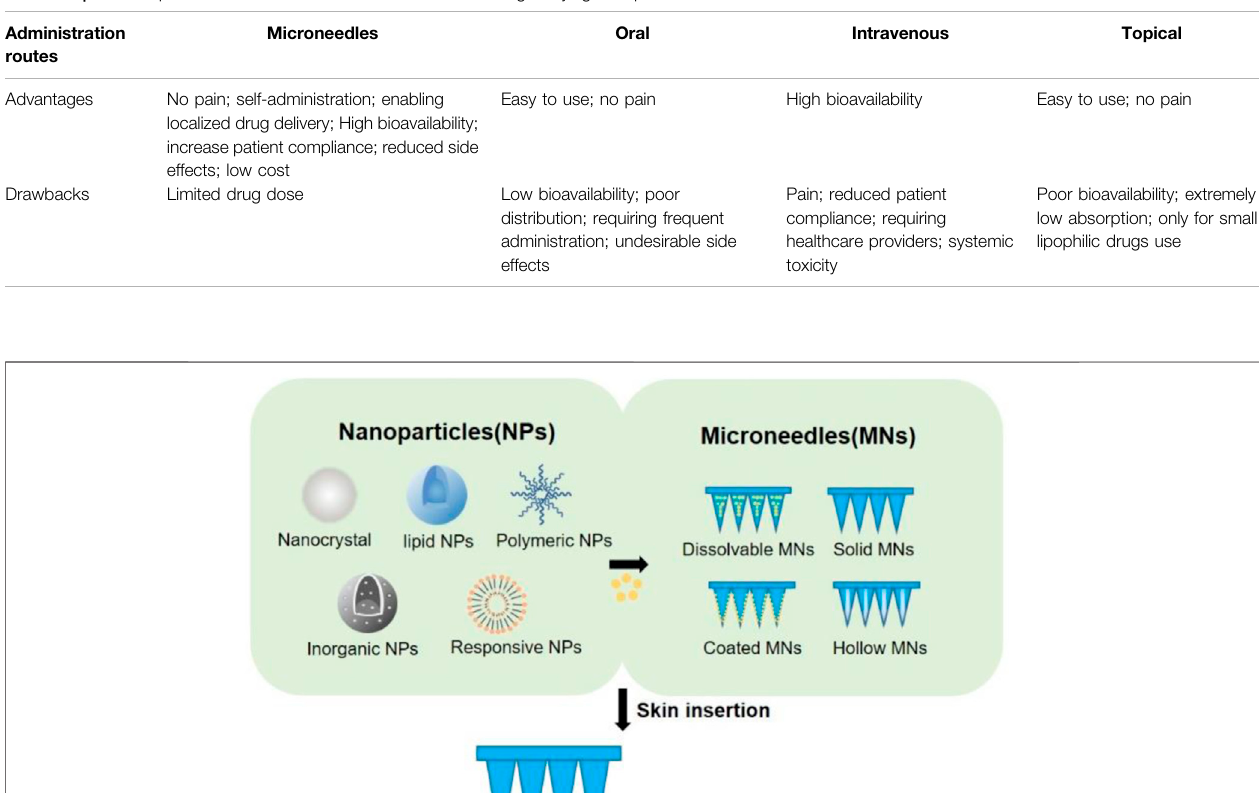
Frontiers in Bioengineering and Biotechnology |